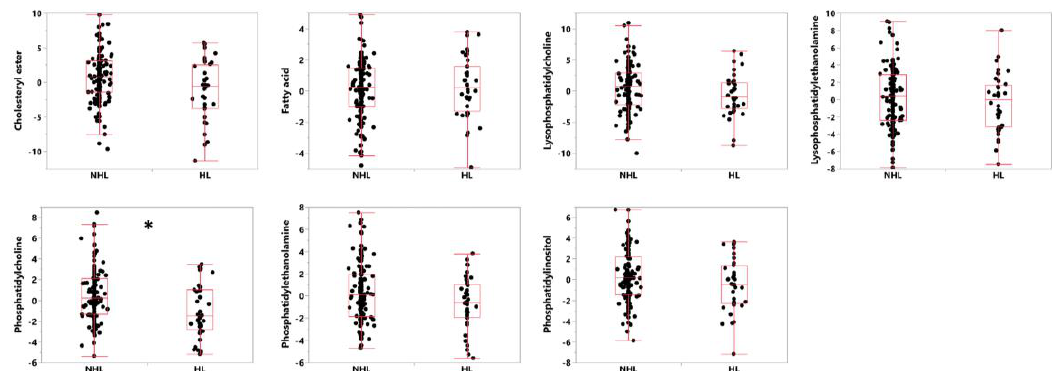
Figure 1. Box plots showing the median, first and third quartiles of the distributions, demonstrating differences in levels of lipids in the seven classes of lipids identified as parts of sets 4 and 23 from [23], distinguishing between HL and NHL in subjects with Alzheimer’s disease. Shown are standardized values (centered by mean and divided by standard deviation), after adjusting for age and gender as covariates. * Bonferroni-corrected p -value of < 0.05.